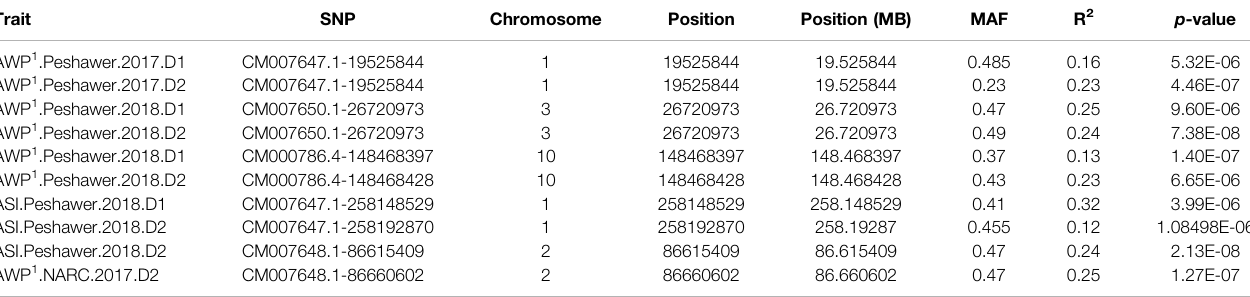
TABLE 4 | Common SNPs signi fi cantly associated within and between target traits in diverse maize inbred lines. Trait